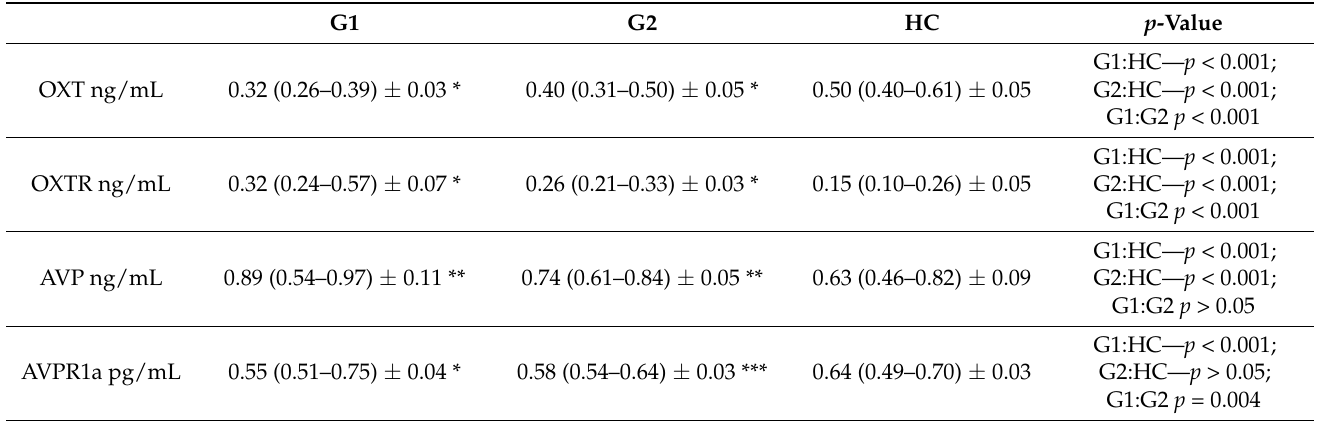
Figure 1. OXT gene expression at the mRNA and protein levels in the studied population. The level of OXT expression at the protein level was statistically significantly different between all study groups (H = 78.05; p < 0.001). Dunn’s multiple comparison test showed that the OXT protein level was statistically significantly lower in G1 ( p < 0.001) and G2 ( p < 0.001) than in the control group and was significantly lower in G1 than in G2 groups ( p < 0.001) (Table 2, Figure 1). Table 2. OXT, OXTR, AVP, and AVPR1a gene expression at the protein level. * Statistically signifi- cant difference between all groups; ** statistically significant difference between the control group; *** statistically significant difference between the second study group; p —statistical significance; median (minimum–maximum), ± —standard